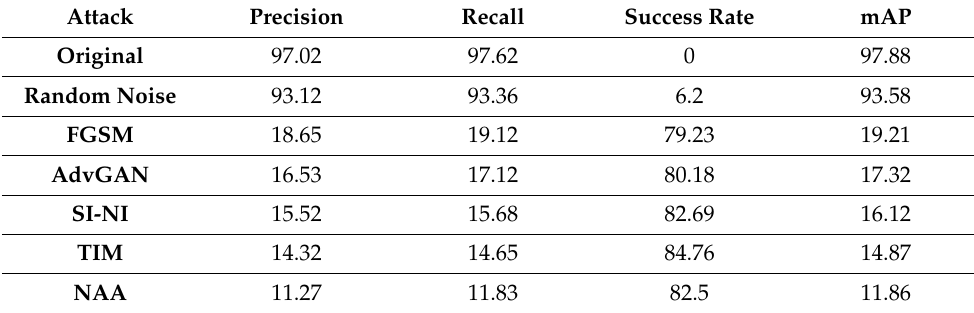
Table 1. Comparison of the effects of different attack methods.